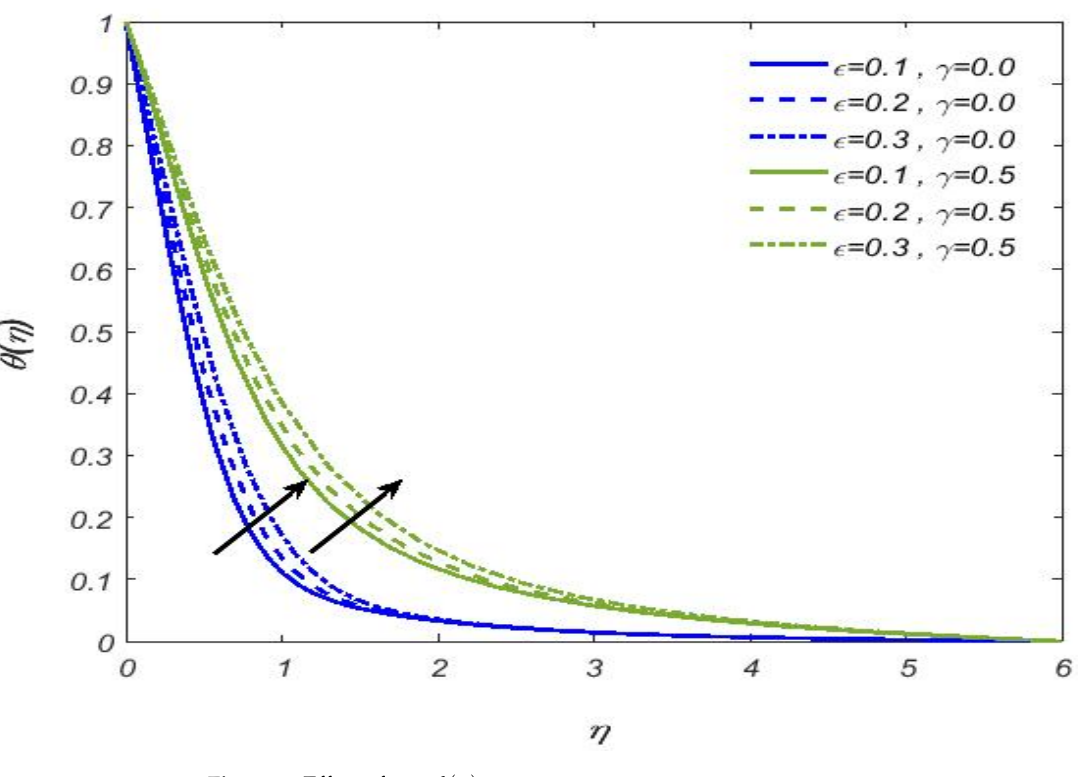
Figure 9. Effect of